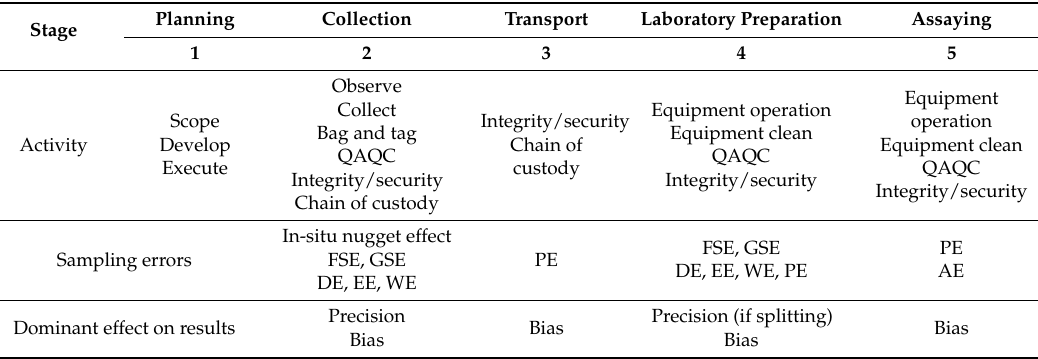
Table 1. Sampling value